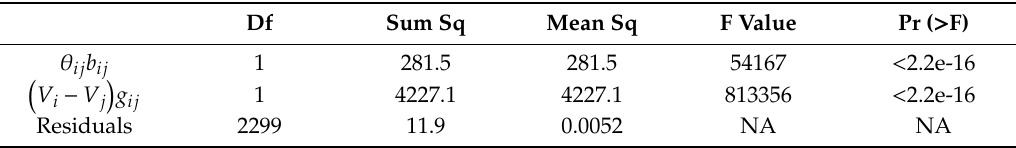
Table 6. Analysis of Variance for Response Variable